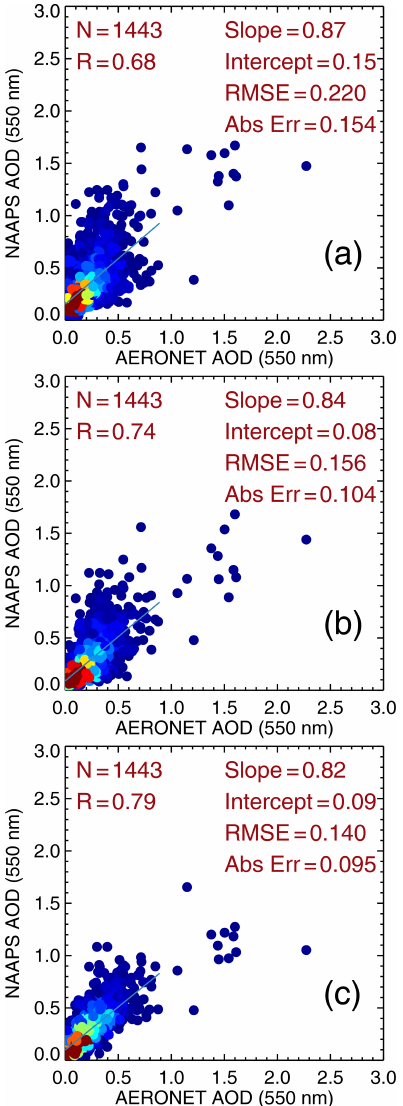
Figure 5. (a) Scatter plot of AERONET and NAAPS AOD (0.55µm) using NAAPS data from the natural runs for July– August 2007 over the study region. (b) Similar to (a) but using NAAPS data from the AI-DA runs. (c) Similar to (a) but with AODs taken from the NAAPS